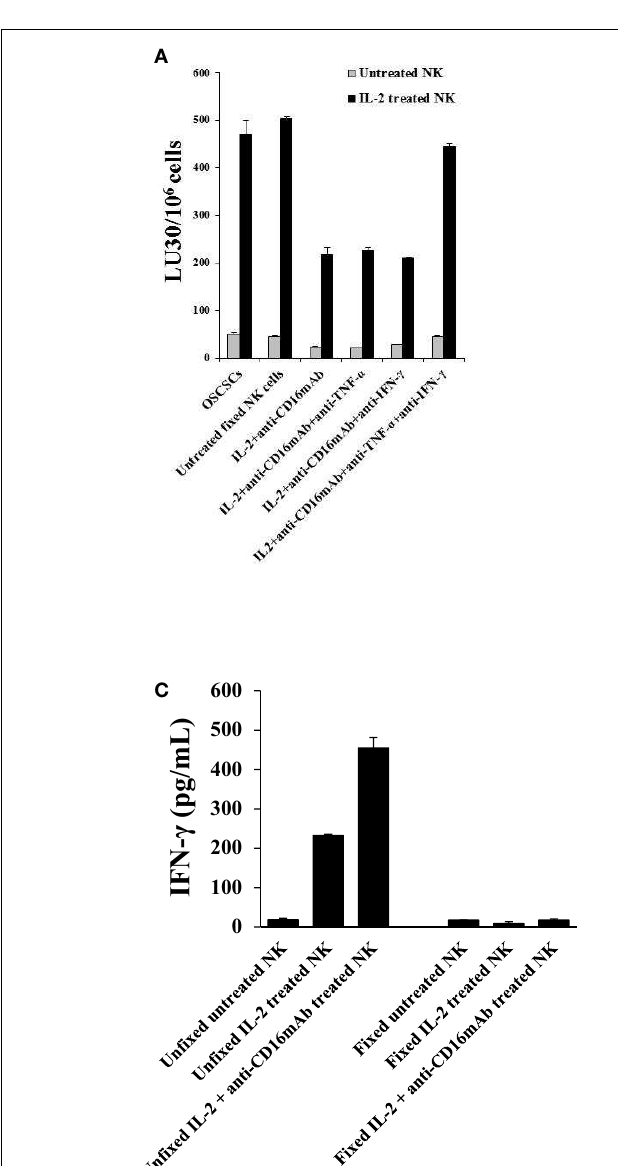
FIGURE 6 | Induction of differentiation, inhibition of cell growth, and resistance to NK cell-mediated cytotoxicity in OSCSCs induced by IL-2 + anti-CD16 mAb-treated and paraformaldehyde-fixed NK cells is mediated by the combination of IFN- γ andTNF- α and not each cytokine alone . Highly purified NK cells were left untreated or treated with the combination of IL-2 (1000units/ml) and anti-CD16 mAb (3 µ g/ml) for 24h, after which the NK cells were fixed with 2% paraformaldehyde and added to OSCSCs (0.75:1 NK:OSCSC ratio) in the presence and absence of anti-TNF-